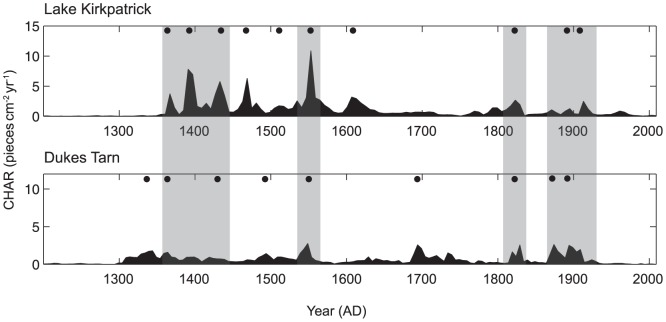
Variation in CHAR (charcoal particles cm−2 yr−1), and peak identification for Lake Kirkpatrick and Dukes Tarn.Black circles identify peaks in CHAR that are statistically significant from background variation in CHAR and are thus likely to be local fires (within 1–3 kms of lake). Shaded areas highlight time periods when fire events were recorded at both lakes.